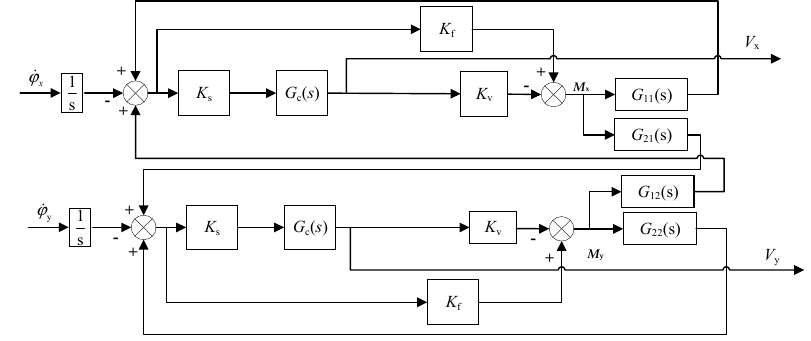
Figure 8. Block diagram of the dual-axis MESG rebalance loop.